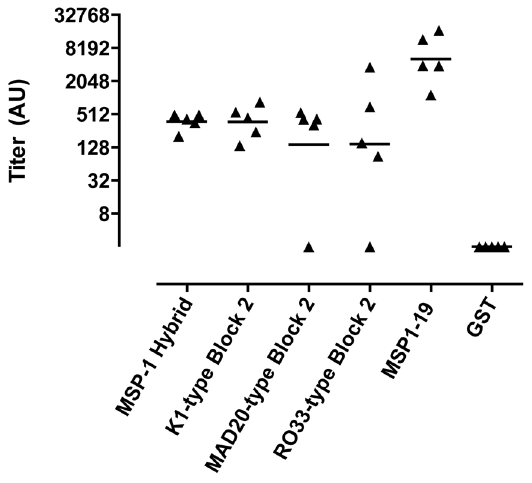
Figure 3. Immunogenicity in mice of recombinant MSP-1-BBM protein from T.thermophila [ 49 ] . A group of five MF1 mice were immunized s.c. three times, at 2 week intervals with MSP-1-BBM protein formulated in CoVaccine HT as described. Twelve days after the last immunization (d40), serum samples from each animal were tested by ELISA for antibody responses against the MSP-1 Block 2 hybrid protein [31] K1-type Block 2 protein [54], MAD20-type Block 2 protein [54], RO33-type Block 2 protein [54] and MSP-1 19 protein [53]. Titers were calculated as outlined in materials and methods and expressed as arbitrary units (AU). Data is shown on a natural logarithmic scale as dotplots of serum reactivity for individual animals with the median level of Ab reactivity indicated by the solid horizontal